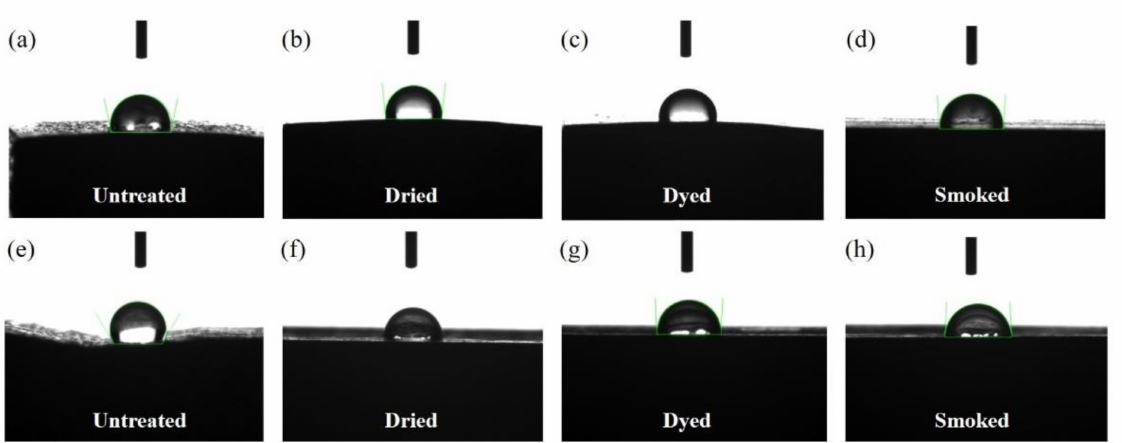
Figure 8. Contact angle measurements taken from ( a – d ) the outer and ( e – h ) inner sections of untreated and modified bamboo specimens by the Phoenix 300 contact-angle system; the contact angle was calculated by using the Imagej software.